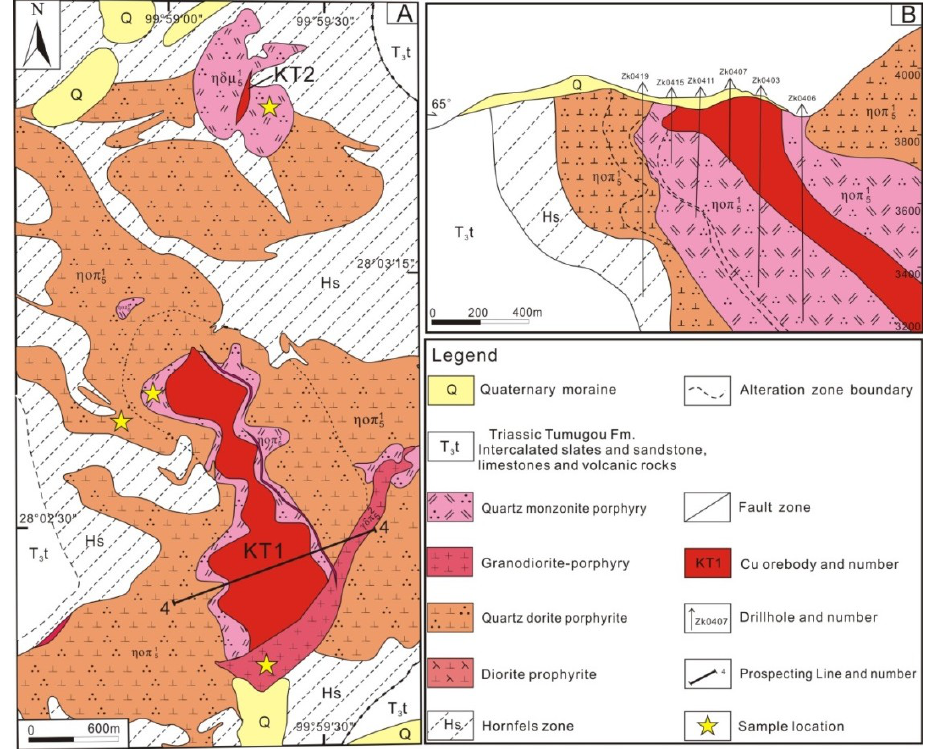
Figure 2. ( A ) Geological map of the Pulang porphyry Cu (–Mo–Au) deposit showing the biggest orebody KT1 and KT2 (based on Wang et al. [14]). ( B ) Geological section of the No. 4 exploration line